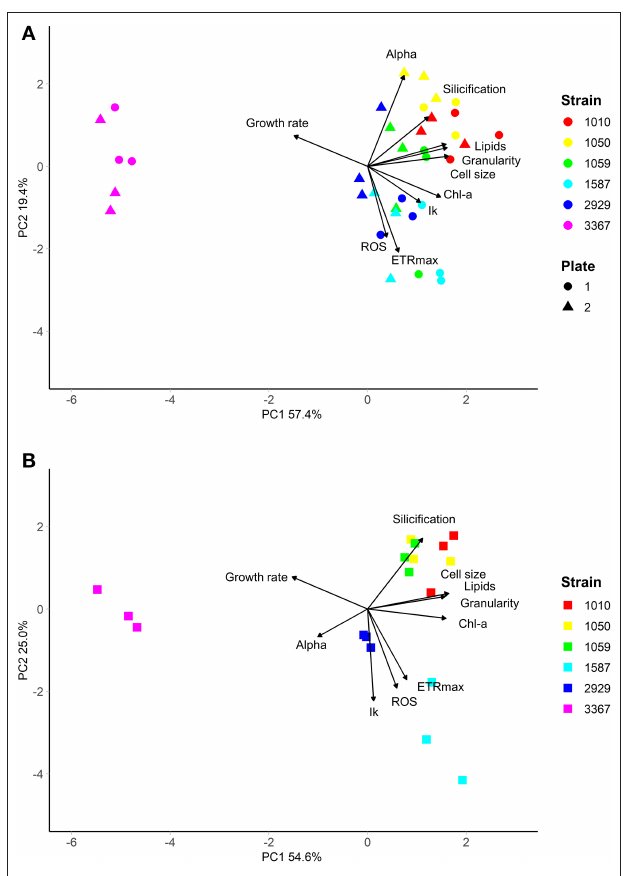
FIGURE 2 | Multivariate phenotypes of six Thalassiosira strains grown in either (A) multiwell plates ( n = 6 per strain, split across two independent plates), or (B) 50mL tissue culture flasks ( n = 3 per strain), visualised using Principal Component Analysis. Strains were grown in in artificial seawater (ASW) with f/2 media ( Guillard, 1975) at 20 ◦ C, with 60 µ molm − 2 s − 1 of light on a 12:12 light cycle. Strains are shown in different colours.